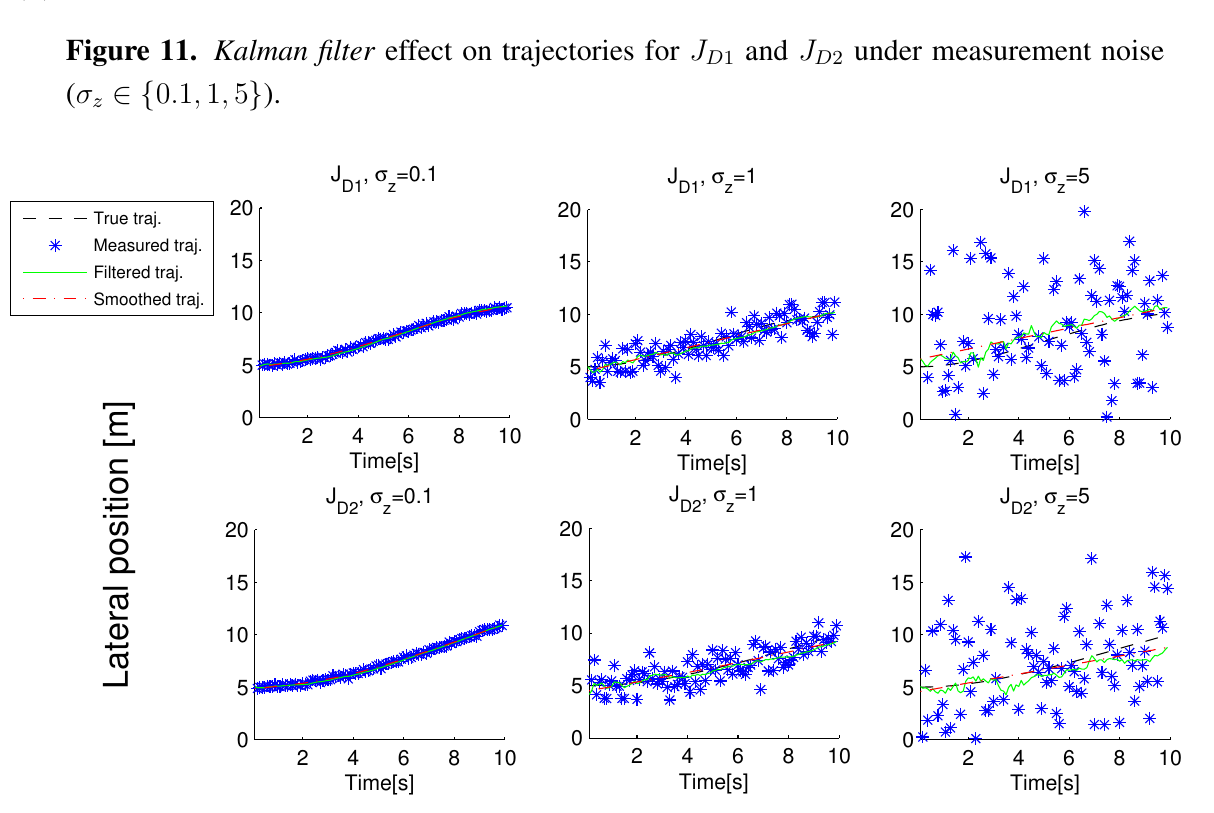
and J under measurement noise D 1 D 2